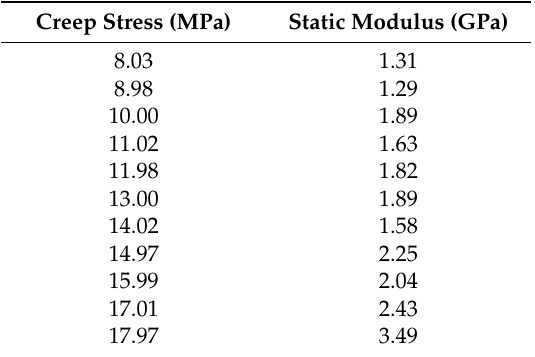
Table 3. Static moduli attained from uploading